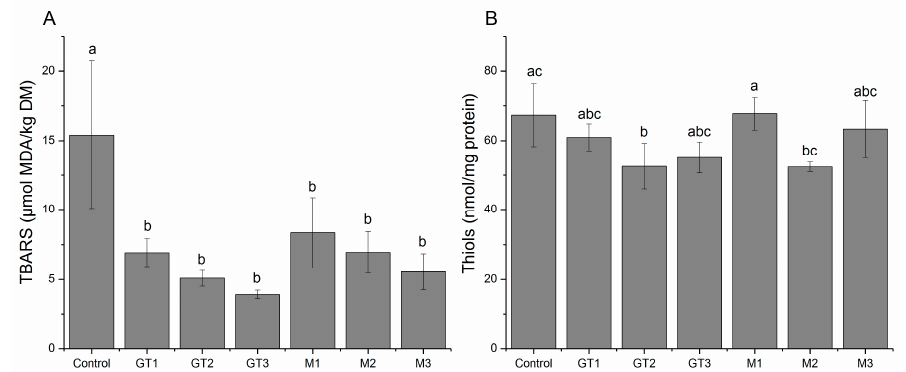
Figure 2. ( A ) Secondary lipid oxidation products as determined by TBARS (µmol MDA equivalents per kg dry matter) and ( B ) protein thiol concentration (nmol/mg protein) in pork chops injected with three different concentrations (denoted 1, 2, or 3 corresponding to 25, 80, and 160 ppm phenolic compounds, respectively) of green tea (GT) or maté extract (M) and chill stored in high-oxygen modified atmosphere packaging (MAP) for 7 days. Different letters (a–c) denotes significant ( p < 0.05) difference between samples.